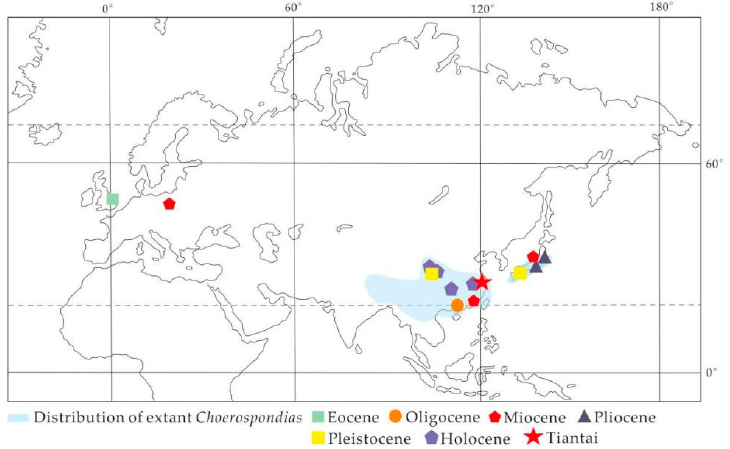
Figure 1. Distribution of extant and fossil Choerospondias (modified from [18]). The extant distribution of Choerospondias axillaris in Asia is shown in the light blue area. The symbols indicate fossil sites of Choerospondias in different geological ages. The red asterisk represents the fossil site in eastern